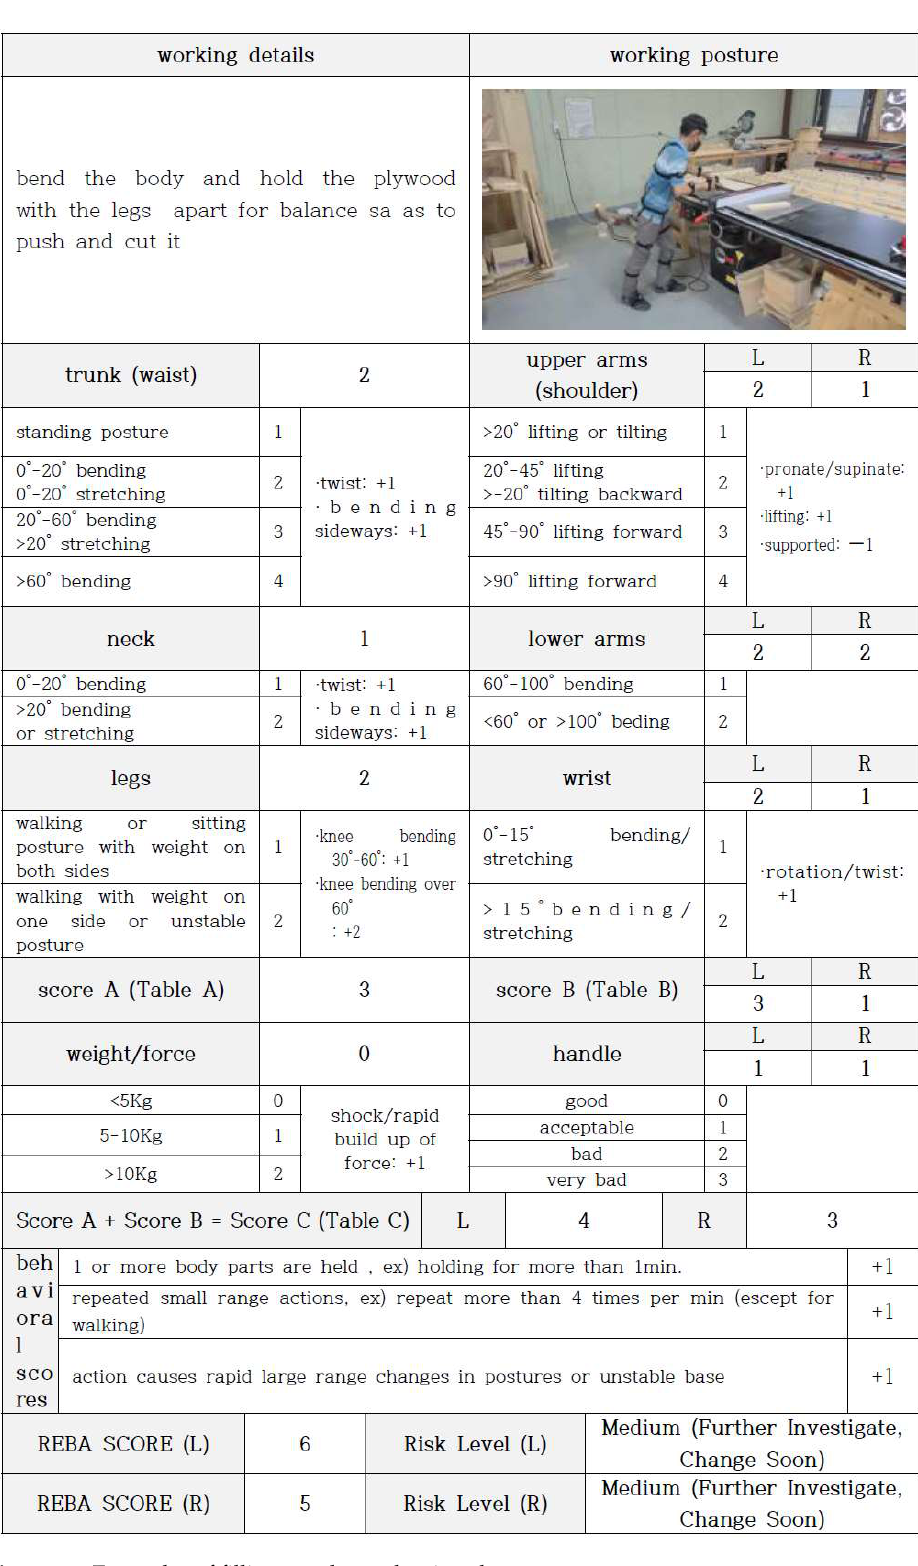
Figure 20. Examples of filling out the evaluation sheet.